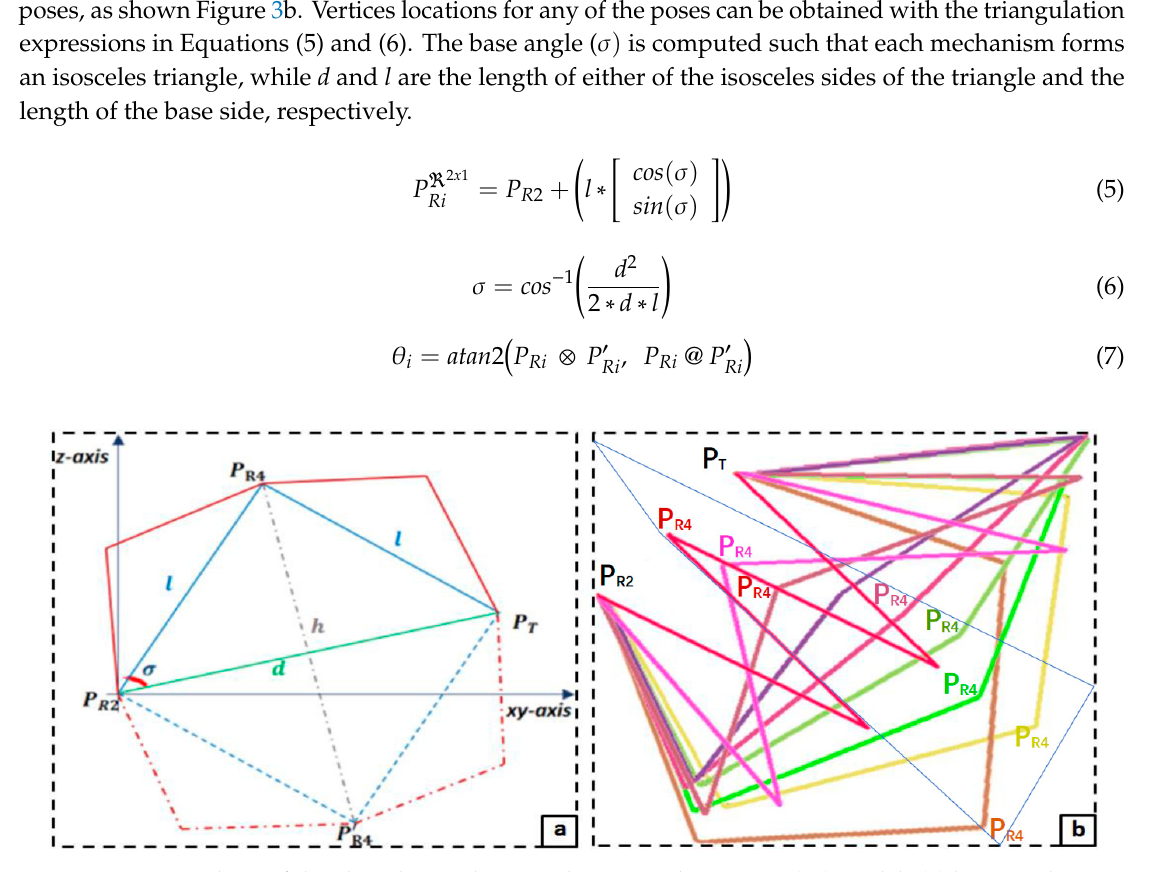
Figure 3. Analysis of the obstacle avoidance in the inverse kinematics (IK) model: ( a ) locating the mid-point for the IK computation and ( b ) alternative poses of a flexible four-DoF robot based on different values of the base angle ( σ ).